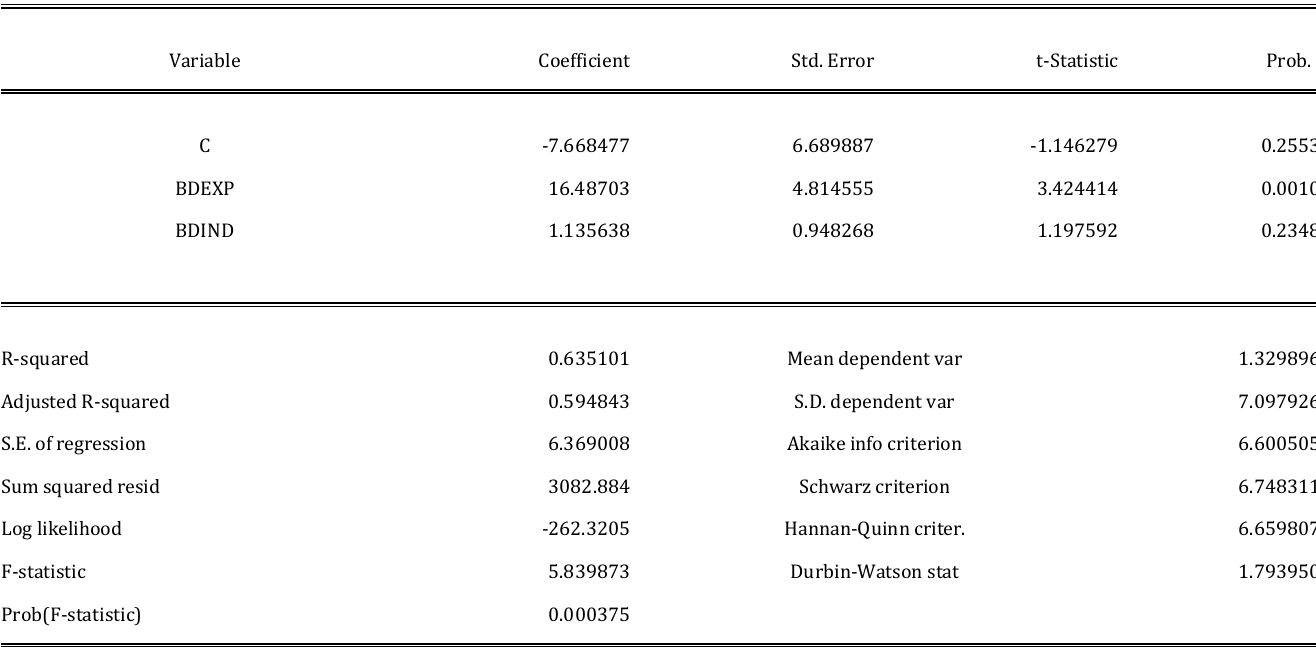
Table 3: Regression